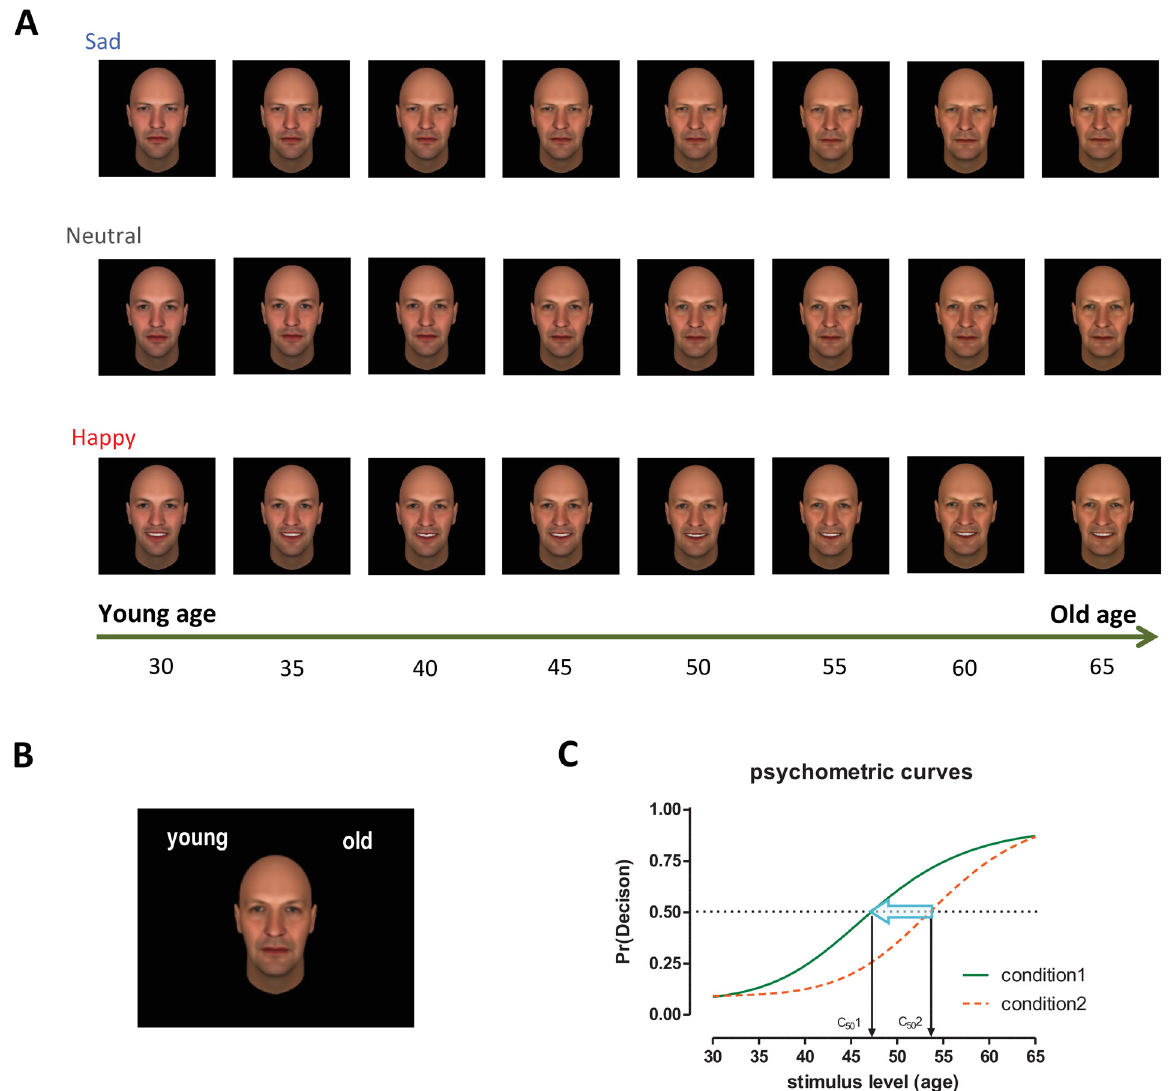
Fig 1. A. Experimental stimuli used for the age judgment task. All facial stimuli were computer-generated and no actual faces were used in our study. The emotional expression (sad, neutral, or happy) and age of the facial stimulus were manipulated by using morphing software. Faces of all emotional expressions have eight equivalent age gradients ranging from 30 years old to 65 years old increasing by 5-year increments. B. Sample screen of the young-old judgment task. Participants were asked to make an age decision in two-alternative forced-choice (either young or old) procedures. The positions of young and old labels were counterbalanced across participants. C. Psychometric curves (Naka-Rushton contrast response model). X-axis represents stimulus intensity level and Y-axis represents response probability. In our experiments, the stimulus intensity represents the incremental increase of age of morphed faces (30 to 65 years old) and the response represents the proportion of old decisions in a forced two-alternative choice task. The C 50 or PSE (Point of Subjective Equality) parameter indicates the perceptual decision threshold. A leftward shift of the psychometric curve (see arrow) would constitute evidence for a decreased perceptual threshold for condition 1 compared to condition 2. doi:10.1371/journal.pone.0152093.g001 centered on a black screen appeared first to indicate the location of the stimuli. The top left and right corners of the screen displayed either the category “ Old ” or “ Young ” in white, 36-point font, with the specific category location (left or right) counterbalanced between participants. A face (400 by 400 pixels), centered on the screen, was presented for 100 ms after the fixation cross. The brief stimulus presentation was employed to eliminate or minimize the occurrence of deliberate eye saccades [21], as similarly done in previous studies [14 – 16, 22, 23]. Also, it has